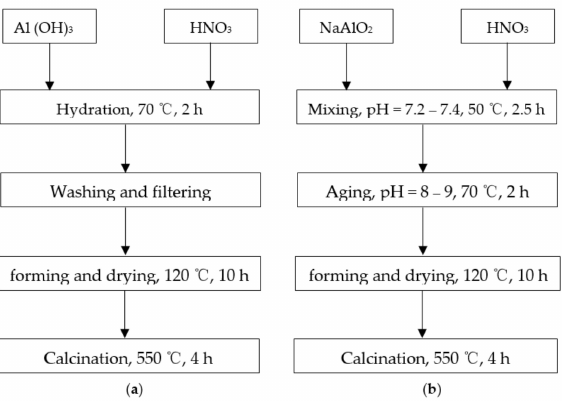
Figure 8. Schemes of syntheses of granular aluminum oxides ( a ) based on the product of the thermochemical activation of gibbsite; ( b ) based on precipitation of sodium aluminate and nitric acid. The process of obtaining aluminum oxide extrudates (C2) is shown in Figure 8b.